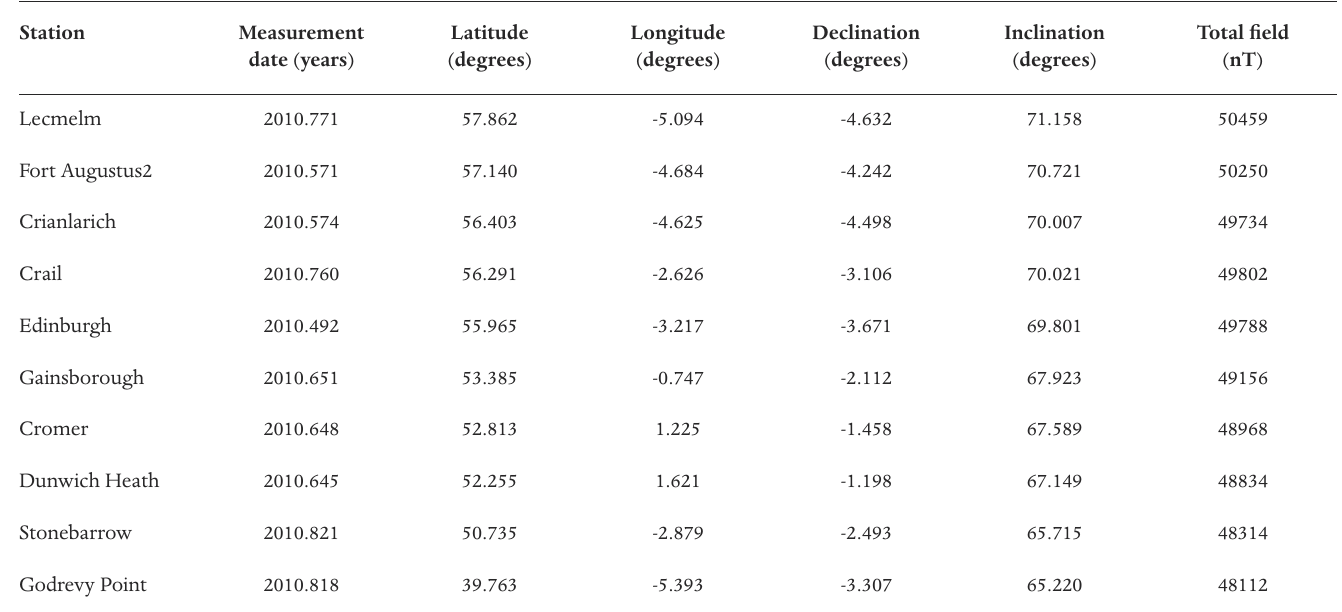
Table 2. 2010 repeat station results (reduced to quiet